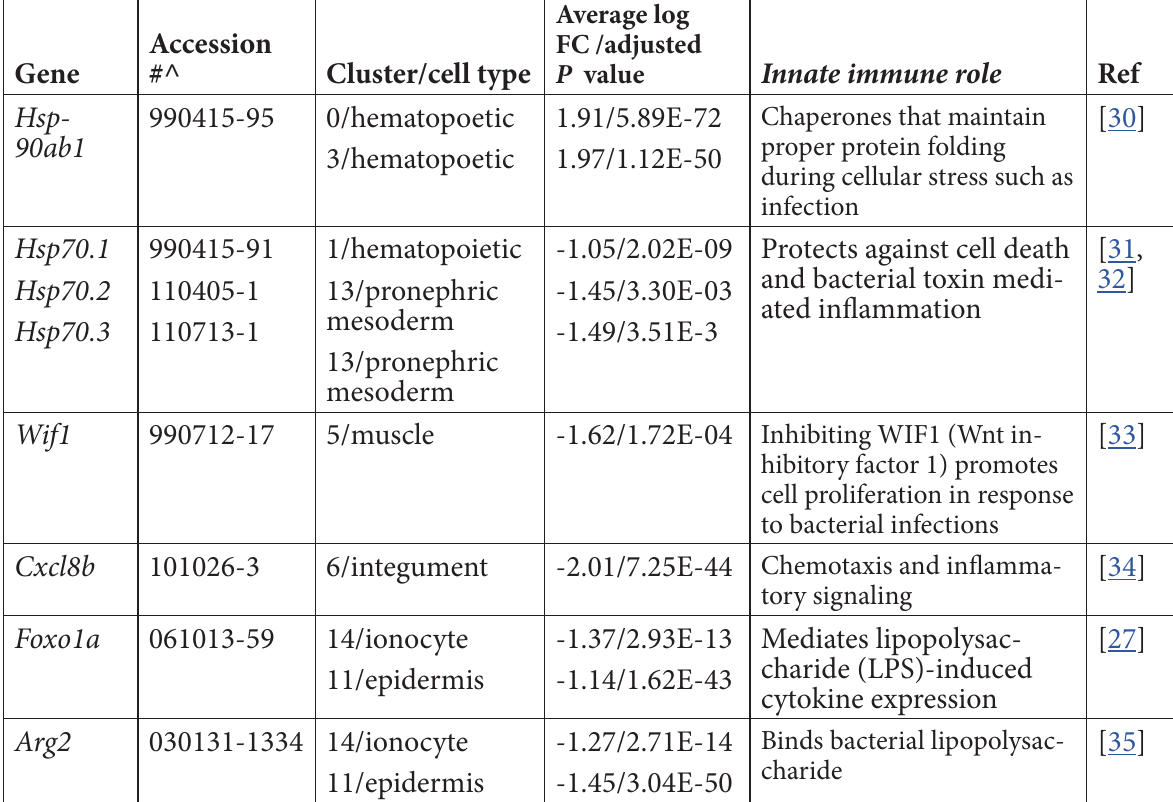
Table 1. Key innate immune genes that are significantly differentially regulated (10 most upregu- lated or downregulated genes) in UPEC vs saline injected zebrafish